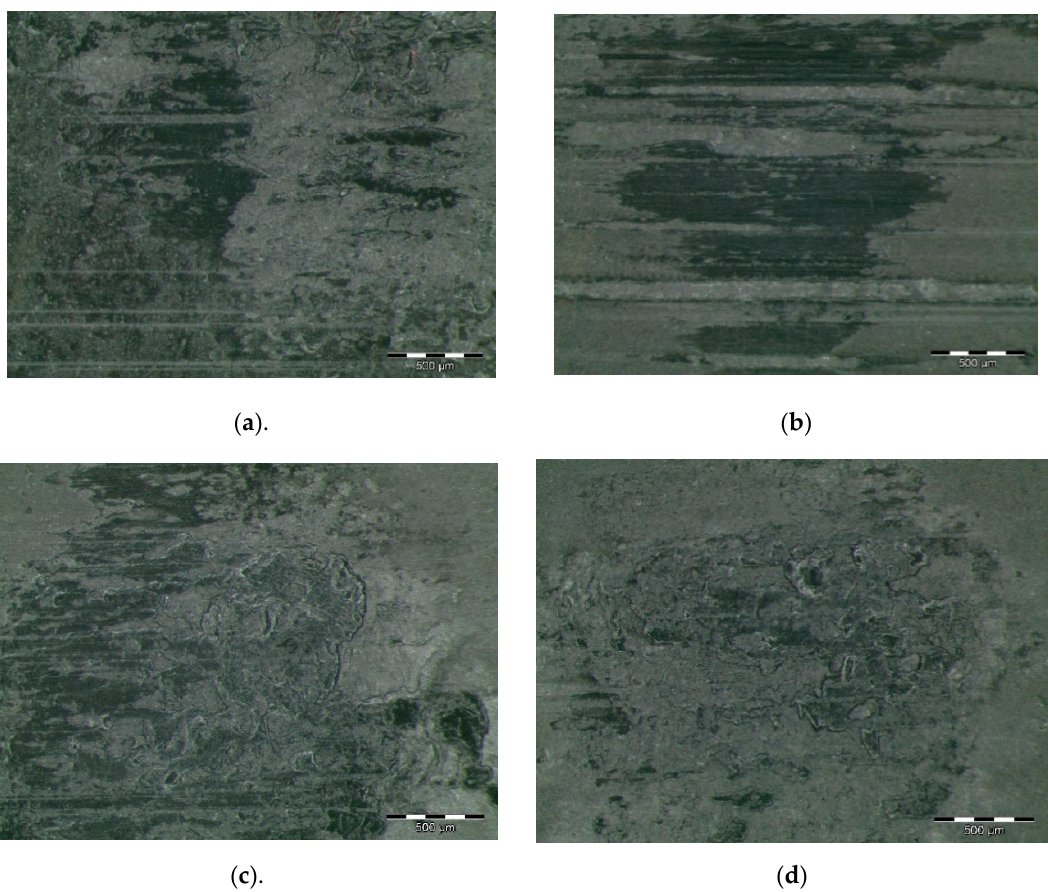
Figure 3. Worn surfaces of PA66 composites: ( a ) PA66 + 5% graphene; ( b ) PA66 + 5% graphite; ( c ) PA66 + 5% MoS2; ( d ) PA66 + 5% ZrO 2 .